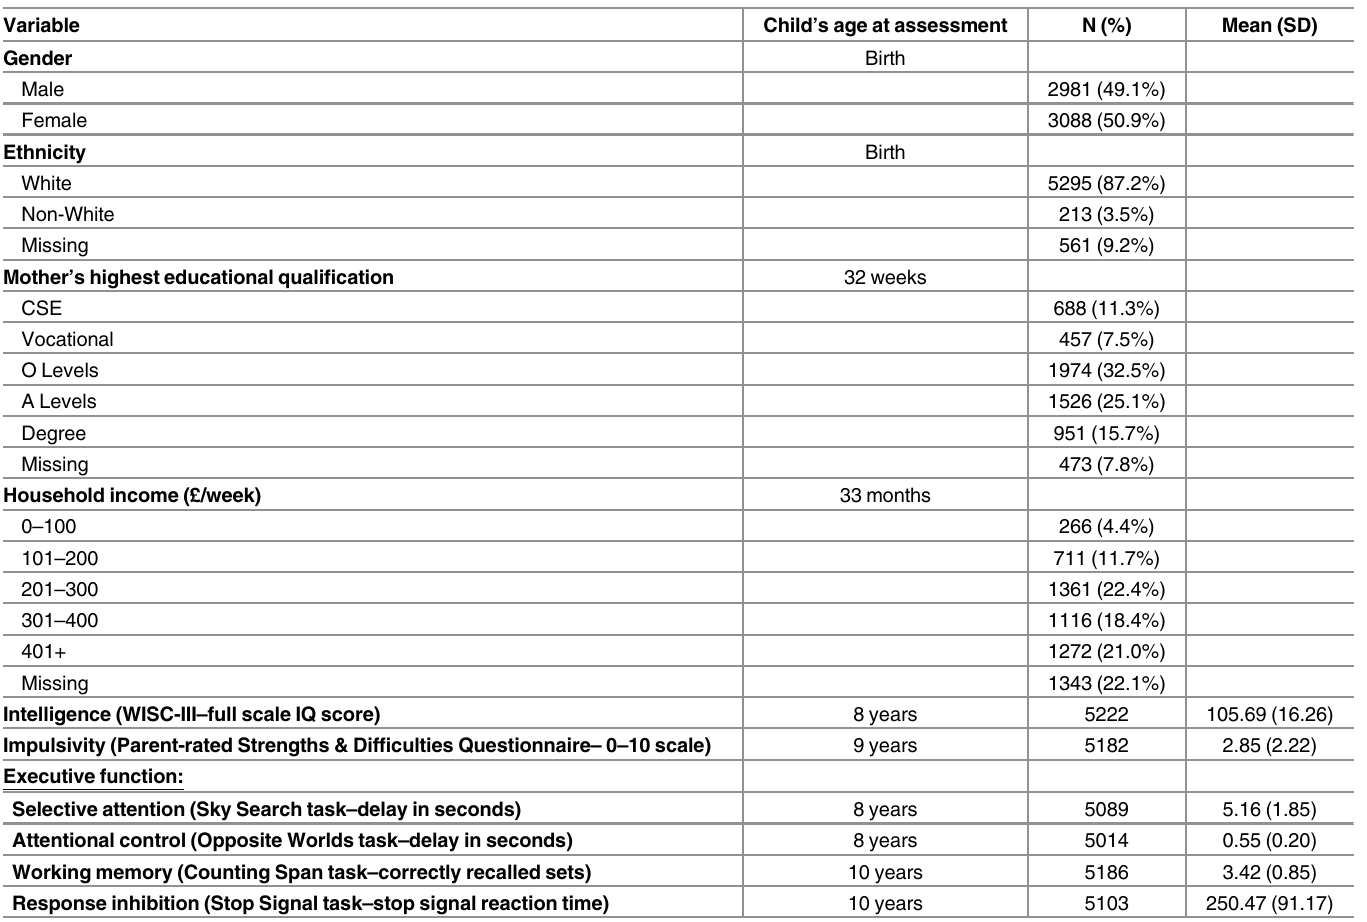
Table 2. Participant characteristics and scores on cognitive